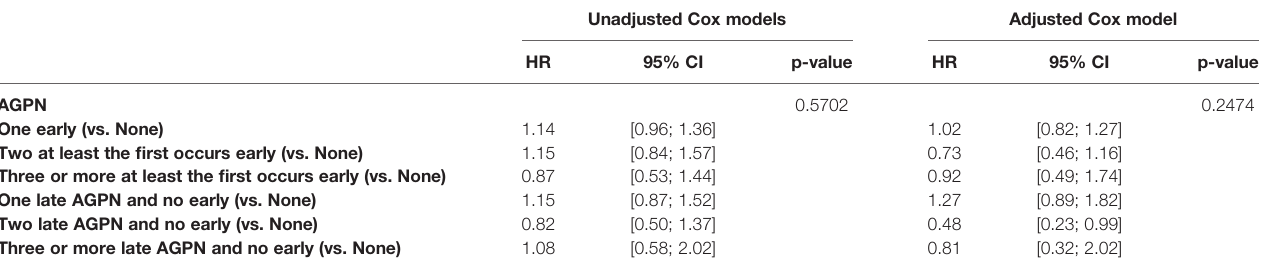
TABLE 5 | Results of the unadjusted (univariate) and multivariable cause-speci fi c time-dependent Cox models strati fi ed on center studying the risk of occurrence of de novo DSA.